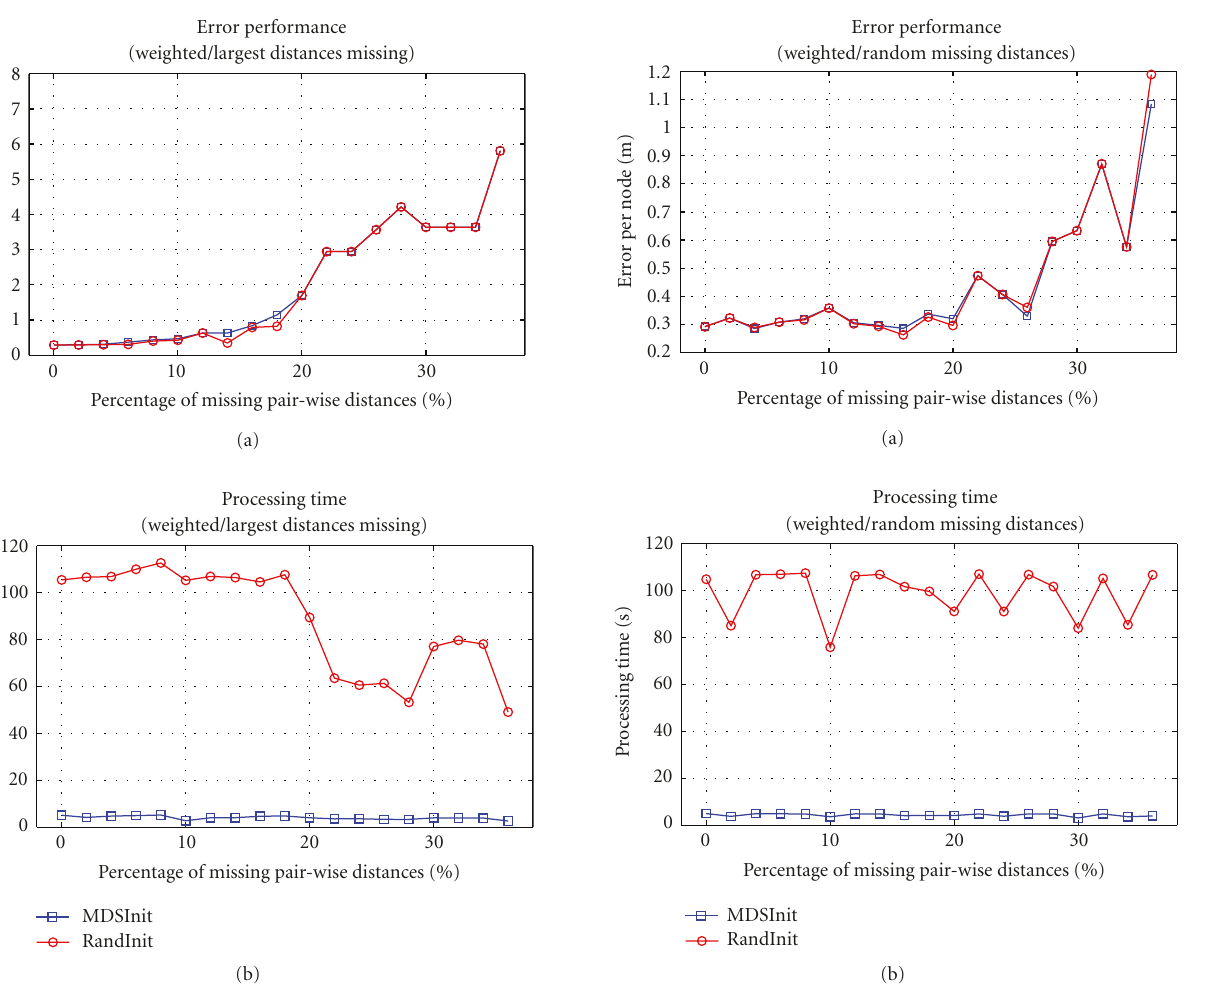
Figure 17: (a) Error performance; (b) processing time versus percentage of missing pairwise distances with standard-deviation adjusted weighting and random missing distances.